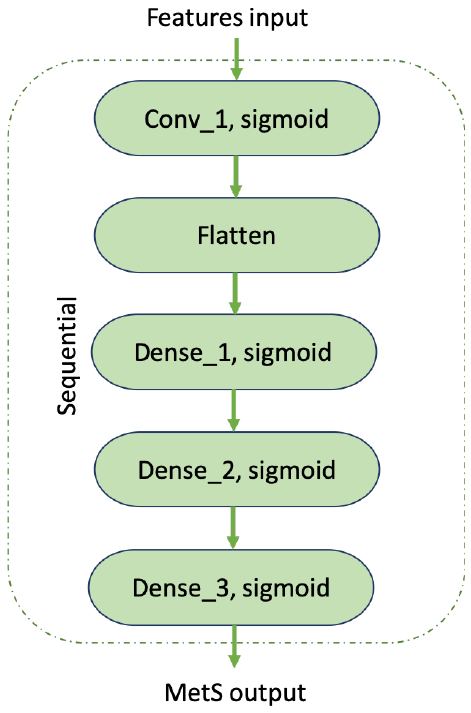
Figure 2. Deep Learning